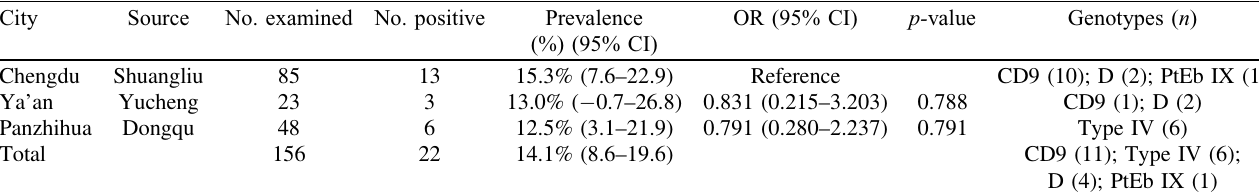
Table 2. Prevalence and genotypes of E. bieneusi in sheltered cats from different cities and sources in Sichuan province, southwestern China. City Source No. examined No.